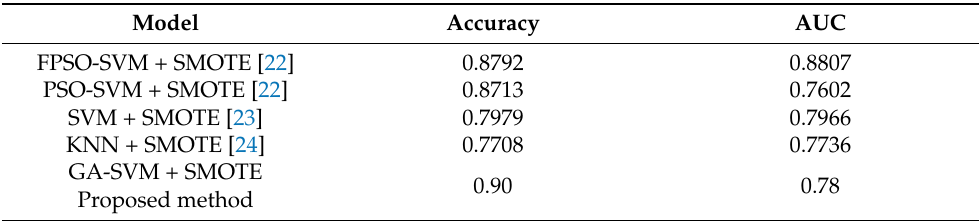
Table 5. Accuracy and AUC comparison for different algorithms on the appendicitis dataset.